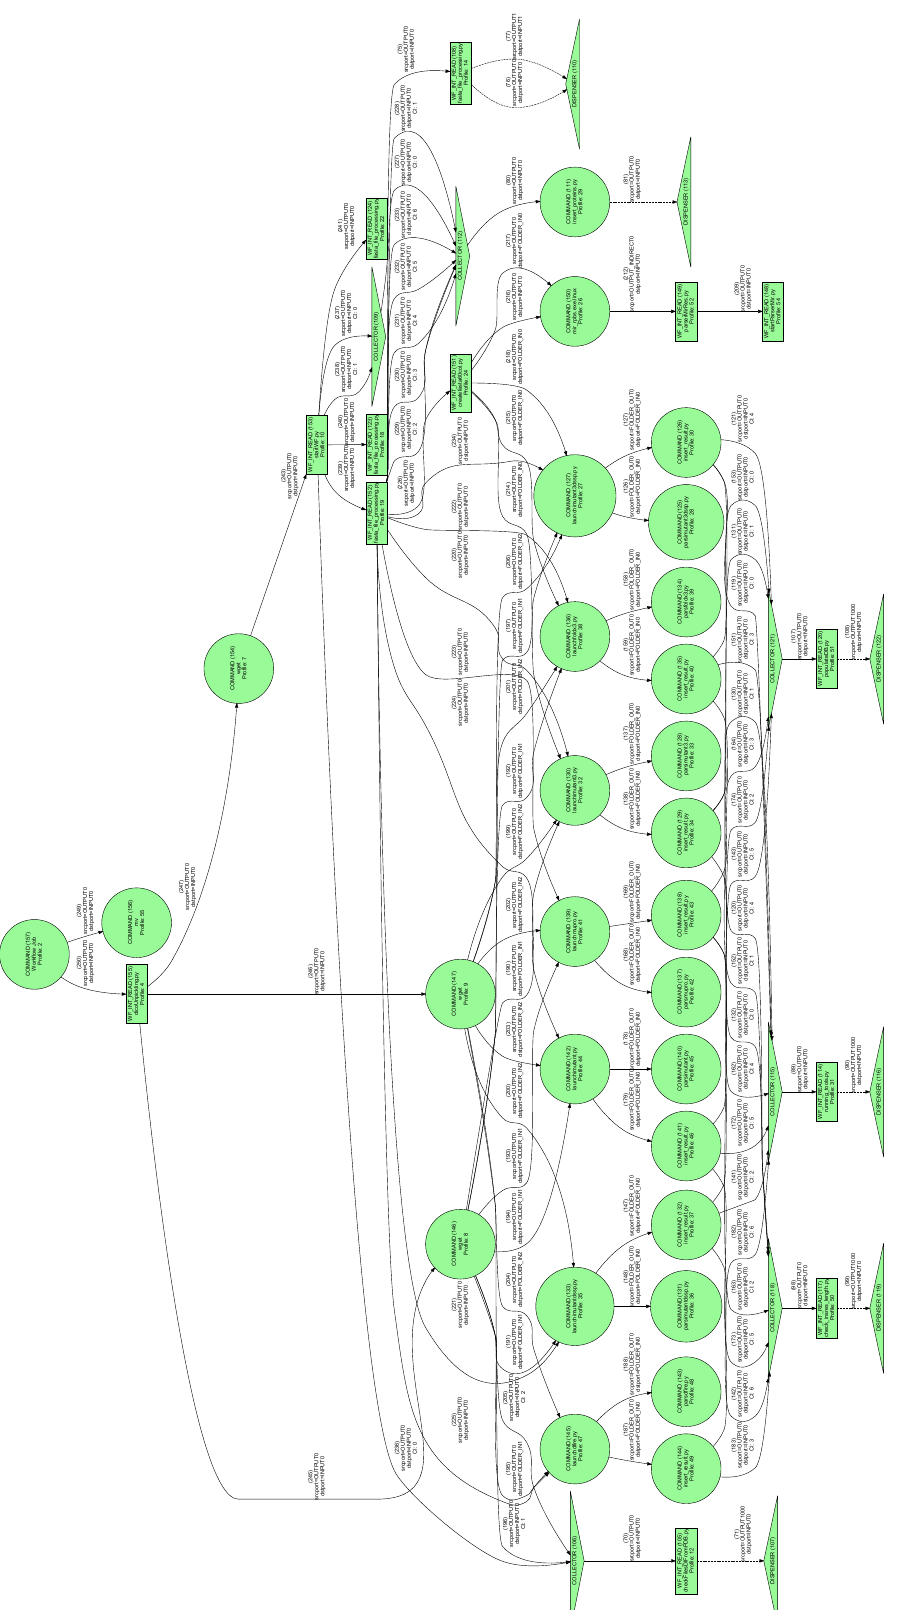
Figure 8: SPROUTS abstract data dependency